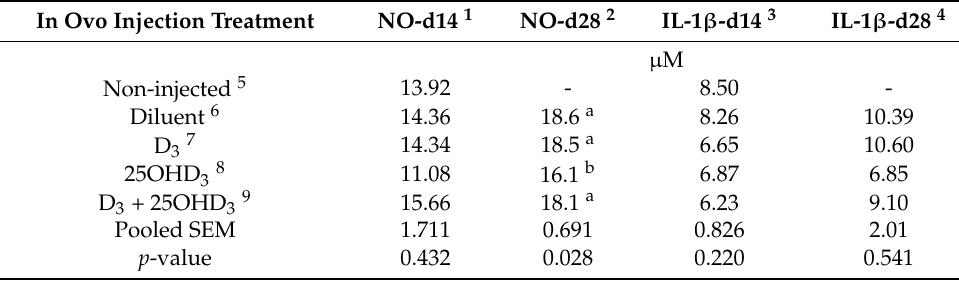
Table 2. Effects of in ovo injection treatment (non-injected, diluent-injected (50 µ L) and 50 µ L